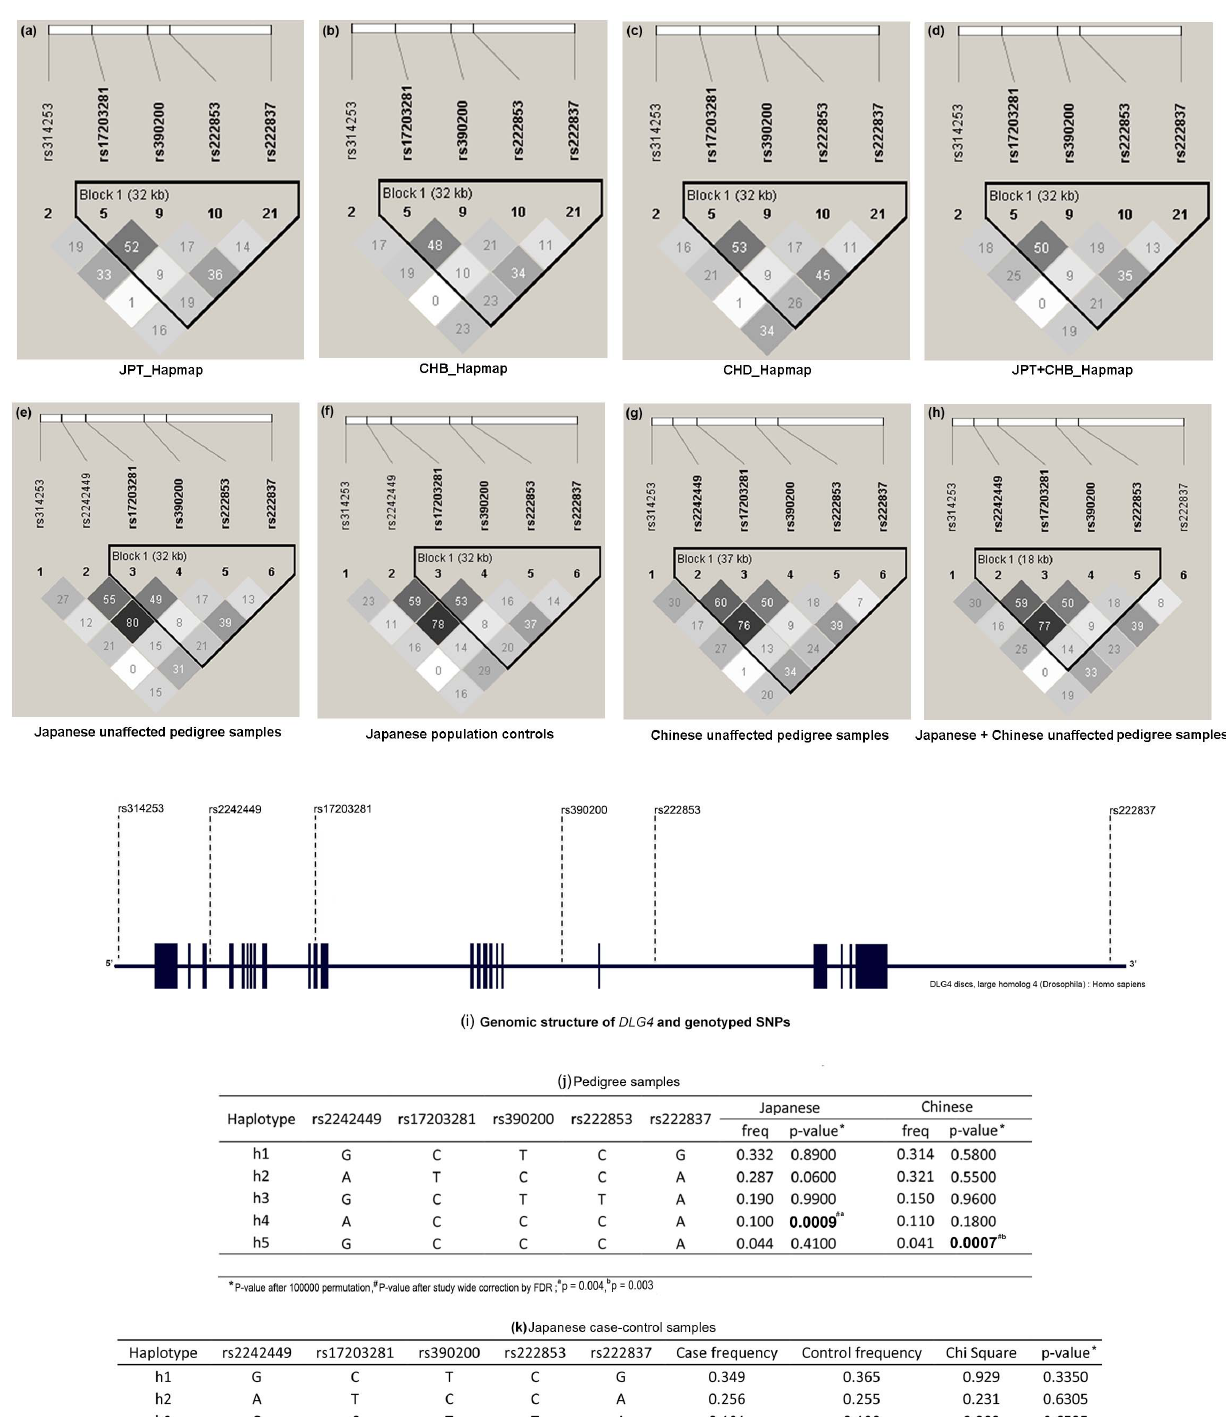
Figure 1. Linkage disequilibrium plots of DLG4 gene of Japanese and Chinese ancestry. (a–d) from Hapmap database, (e–h) unaffected pedigree samples and population controls of the present study,(i) Genomic structure of DLG4 and genotyped SNPs (j) DLG4 haplotypes of schizophrenia pedigree samples and (k) unrelated schizophrenia case-control sample.